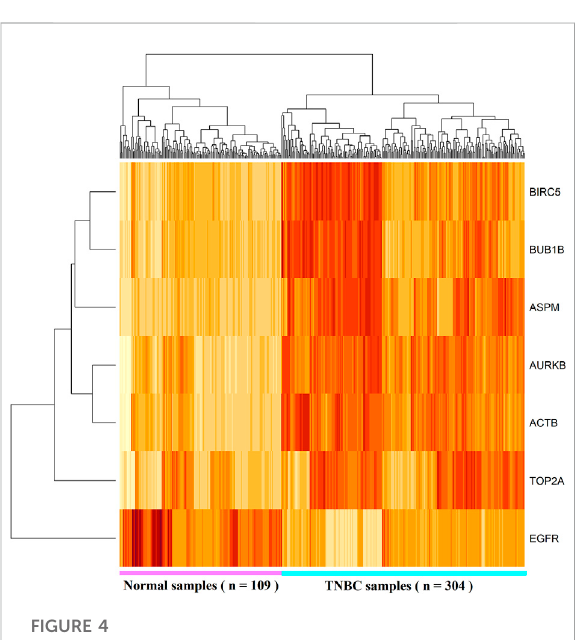
FIGURE 4 Heatmap of hierarchical clustering (HC) results based on the expressions ofseven KGs with 304TNBC and109 control samples (dependent